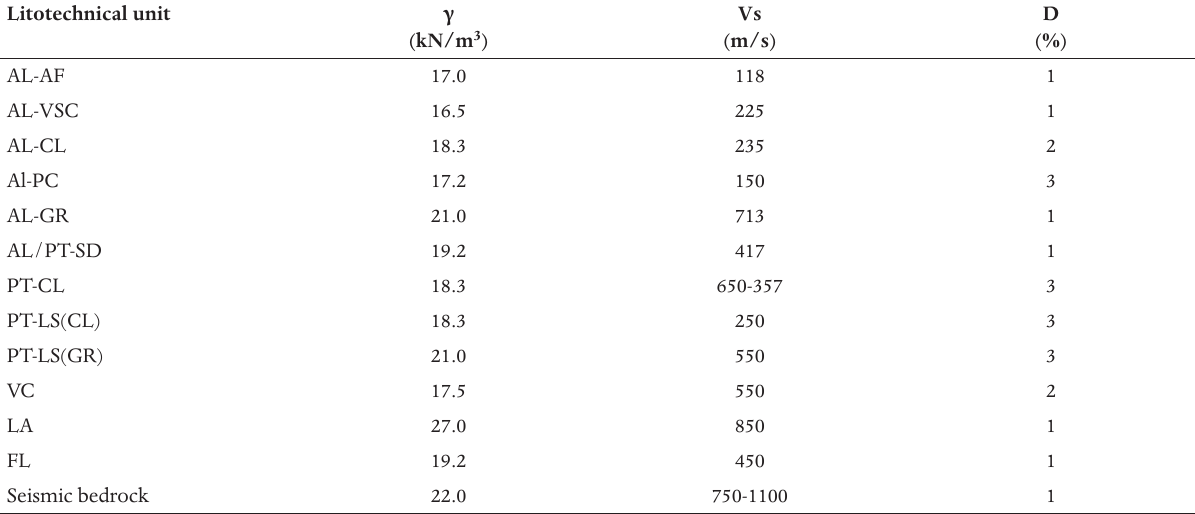
Table 1. Parameter values attributed to the lithotecnical units reported in Figure 4 according to Bozzano et al. [2016]. ( γ : weight per unit volume; Vs: S wave velocity; D: